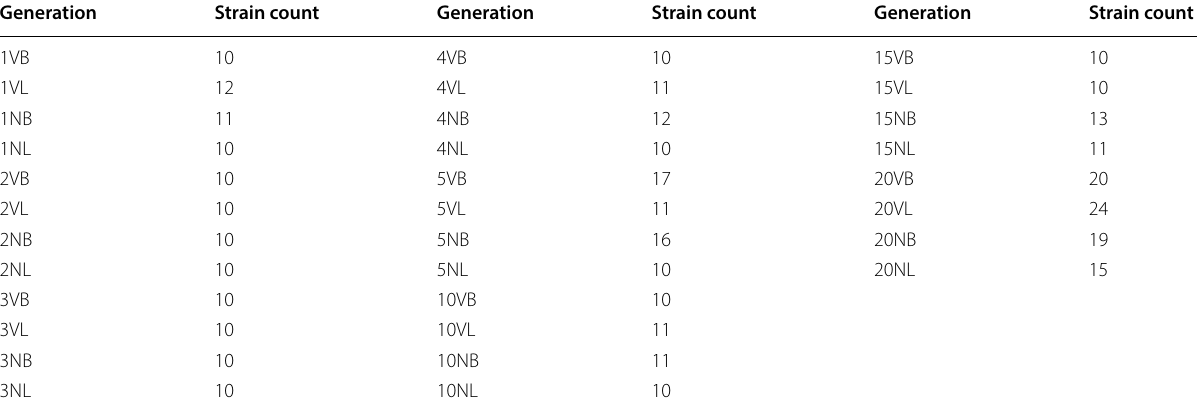
Table 3 The count of quasispecies viruses isolated from lung and trachea tissues with and without vaccine selective pressure Generation Strain